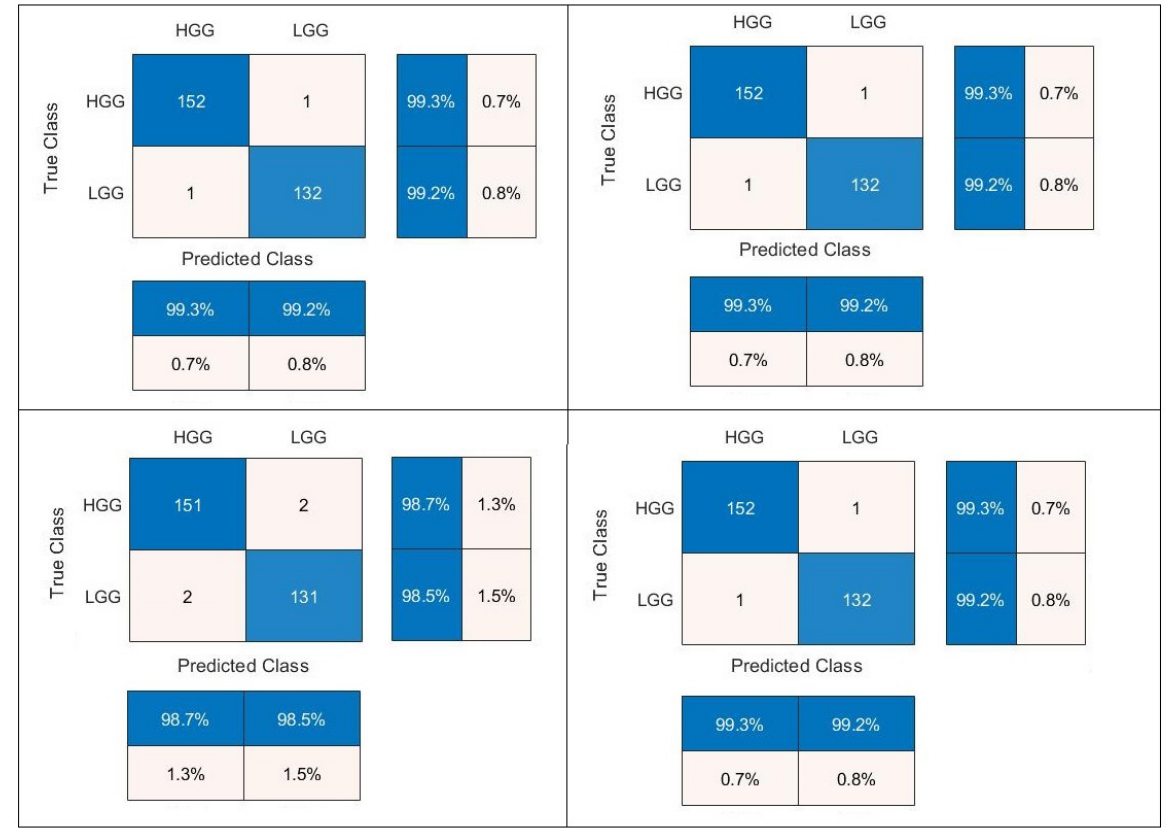
Figure A2. Sample training curve of four rounds of the experiment (ResNet18, FLAIR).